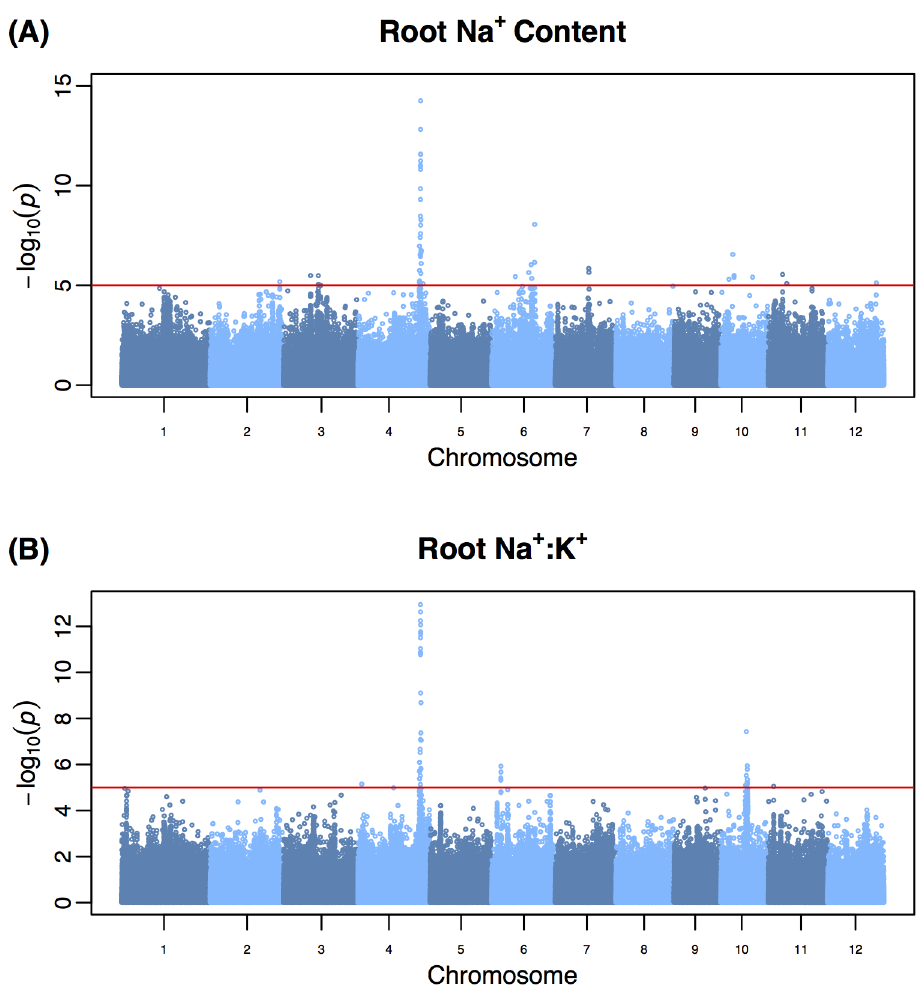
Fig 2. Genome-wide association analysis of Na + content and Na + :K + in root tissue. (A) Root Na + content, (B) root Na + :K + . Genome-wideassociation (GWA) was performed using a mixed model that accountedfor population structure and relatedness betweenaccessions of RDP1 using 365 accessions of RDP1 and 397,812SNPs. For each trait the least squaresmean was used as the dependent variableThe red horizontal line indicates a statistical significancethreshold of p < 10 − 5 , and was determined using the M eff method with an experiment-wise error rate of 0.05